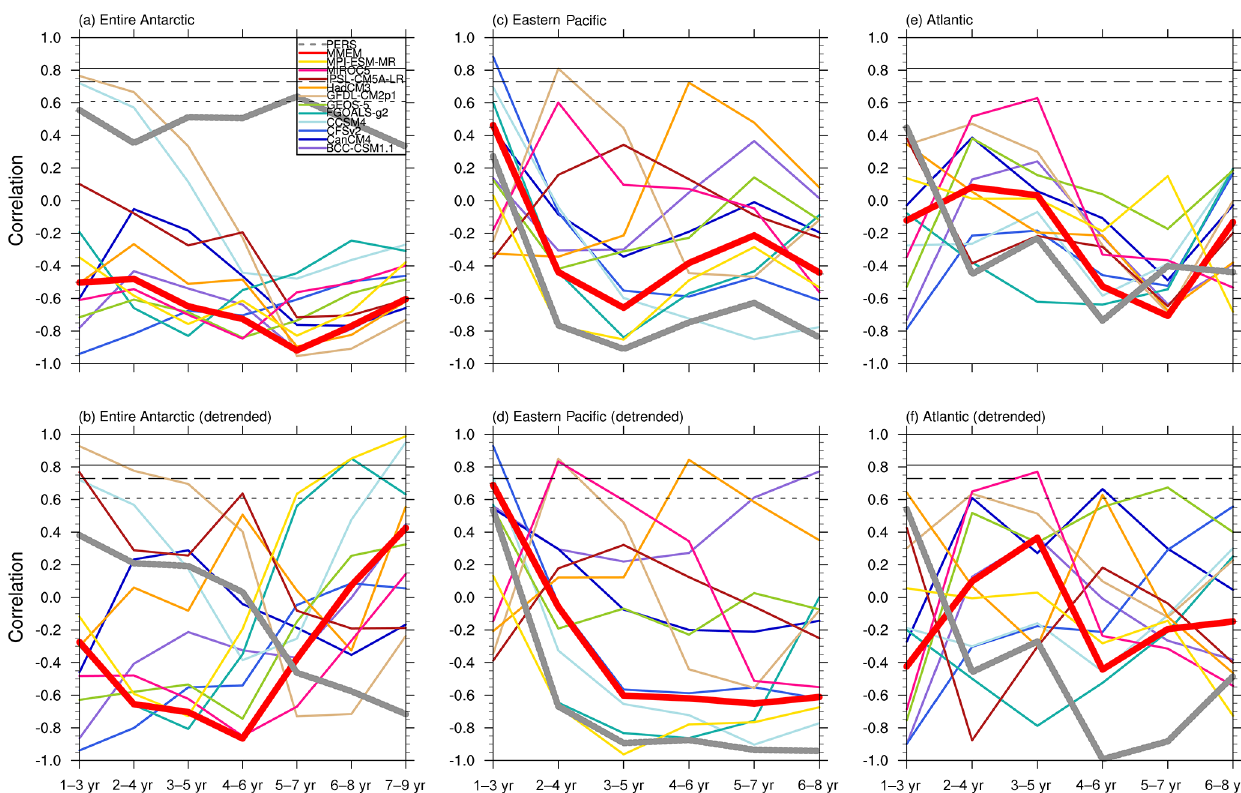
Figure 11. Anomaly correlation coefficients between the simulated and observed Antarctic September sea ice extent anomalies for the three regional indices (the entire Antarctic, eastern Pacific, and Atlantic) as a function of the lead time. The top and bottom panels are the original and detrended time series, respectively. The horizontal dashed and solid lines represent 90, 95, and 99% confidence levels. The thick gray line is the persistence